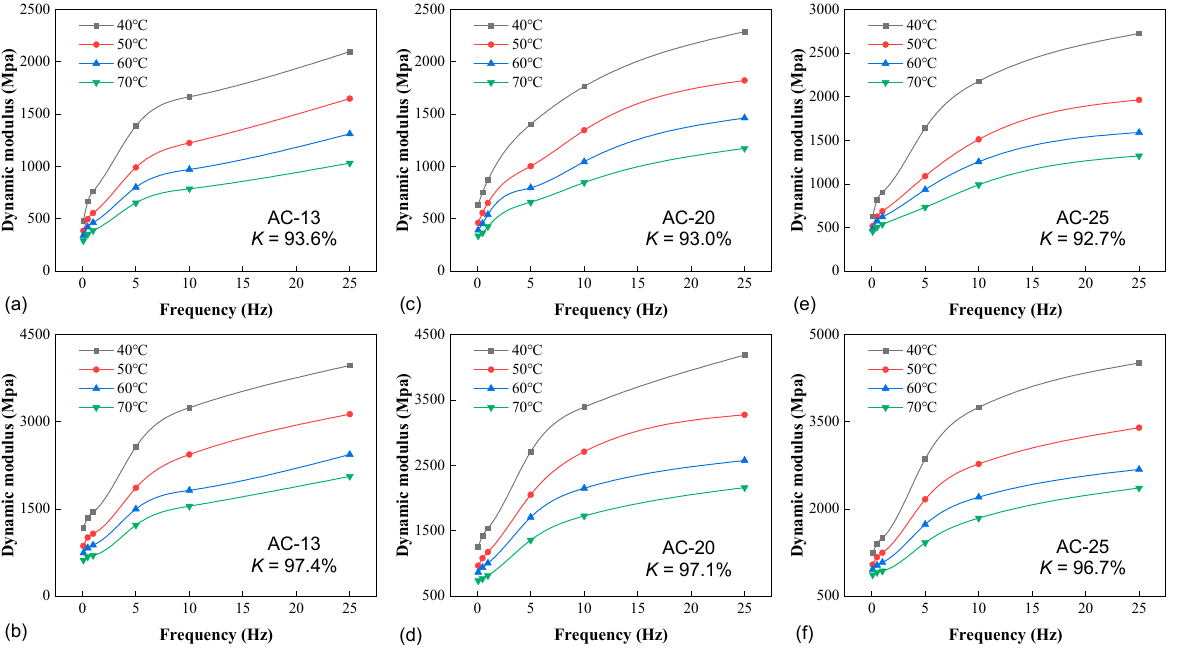
Figure 5. The effect of frequency: ( a ) AC-13 ( K = 93.6%), ( b ) AC-13 ( K = 97.4%), ( c ) AC-20 ( K = 93.0%), ( d ) AC-20 ( K = 97.1%), ( e ) AC-25 ( K = 92.7%), and ( f ) AC-25 ( K = 96.7%).